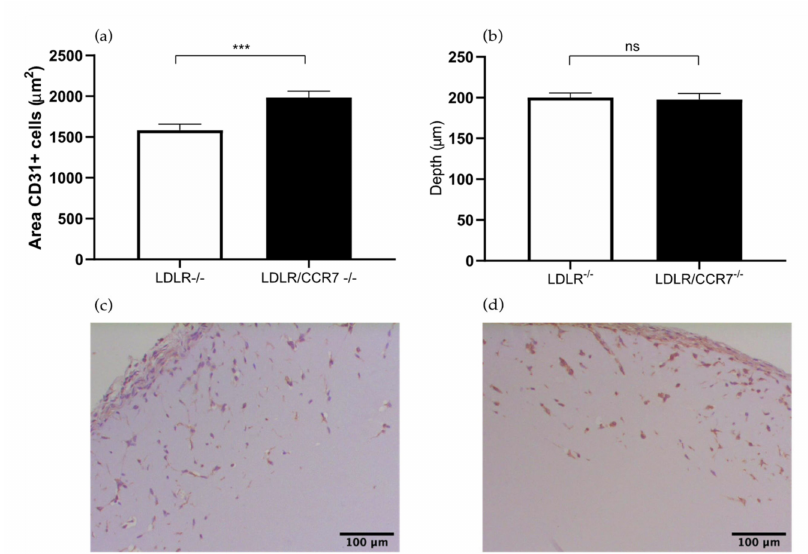
Figure 4. ( a ) Area of CD31 + cells in the subcutaneously injected Matrigel, in LDLR − / − and LDLR − / − /CCR7 − / − mice. ( b ) Quantification of the depth ( µ m) of ingrowth of CD31 + cells into subcutaneously injected Matrigel, in LDLR − / − and LDLR − / − /CCR7 − / − mice. ( c ) Immunohisto- chemical staining of paraffin-embedded Matrigel plug of LDLR − / − /CCR7 − / − mice using anti-CD31 antibodies. ( d ) Immunohistochemical staining of paraffin-embedded Matrigel plug of LDLR − / − mice using anti-CD31 antibodies. N = 7 mice per group, 2 Matrigel plugs per mouse. Values are presented as the mean SEM. *** p ≤ 0.001. ns = not